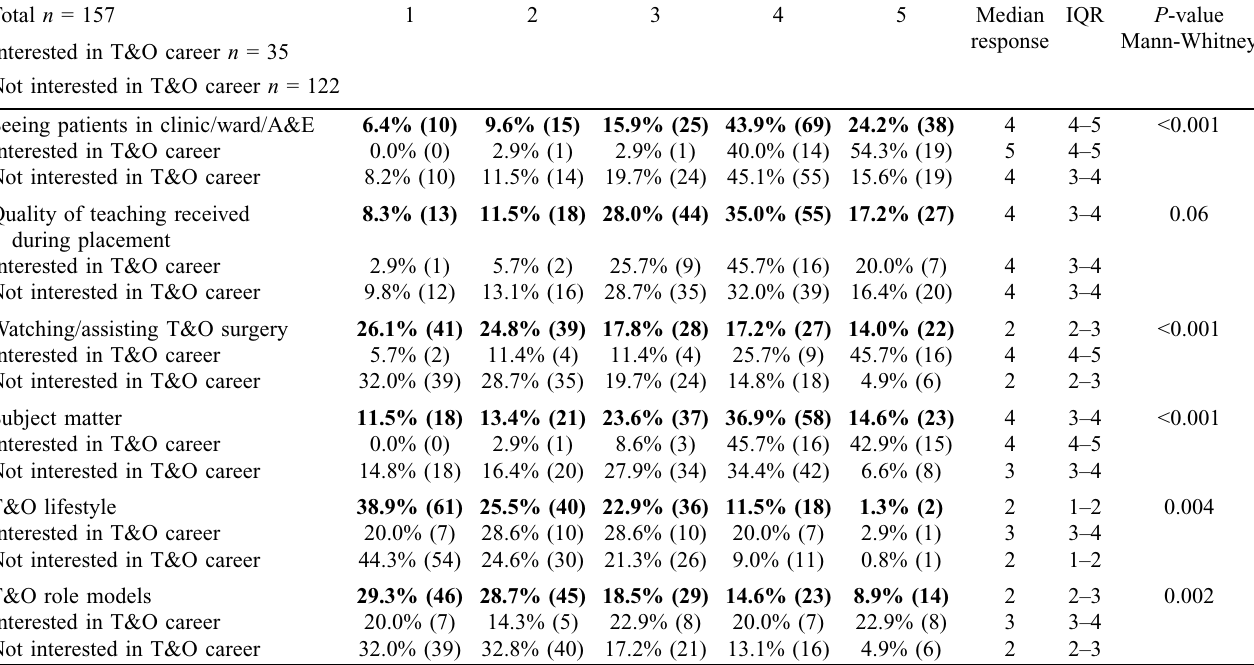
Table 3. Motivating factors towards a career in trauma and orthopaedic surgery. Total n =